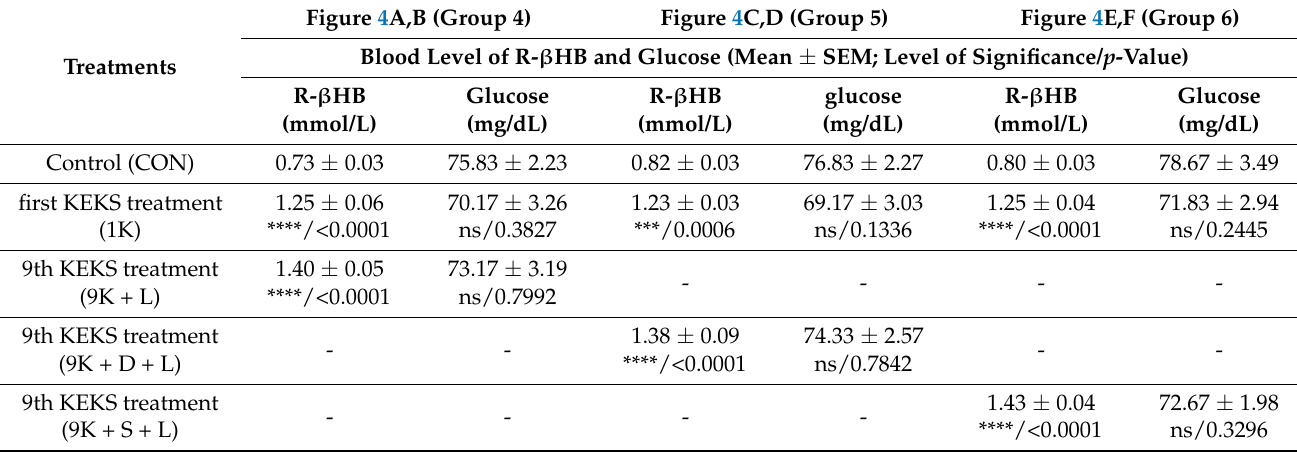
Table 3. Influence of KEKS supplemented food (paste-like standard rodent chow containing 10% ketone ester/KE, 10% ketone salt/KS and 1% saccharin) on blood R- β HB and glucose levels on first (1K) day of administration and on 9th day of KEKS food (K) administration combined with i.p. LPS (L) (9K + L), i.p. DPCPX (D) and LPS (9K + D + L), as well as i.p. SCH58261 (S) and LPS (9K + S + L), compared to control (CON). Figure 4A,B (Group 4) Figure 4C,D (Group 5) Figure 4E,F (Group Treatments